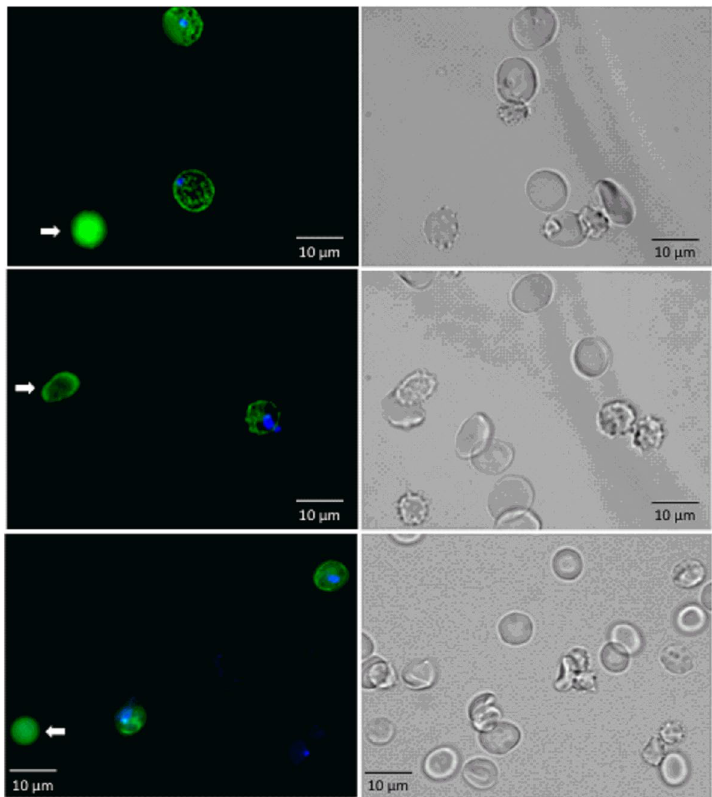
Figure 5. Fluorescence microscopy images of P.f.- RBCs after passing through the microfluidic devices (left column). Infected cells are shown as DAPI + RESA + (blue and green). White arrows indicate pitted cells (DAPI - RESA + , green). Corresponding bright field images of the same fields are shown in the right column. The images were obtained with an epifluorescence microscope (Leica AF6000) and modified using ImageJ software (version 1.41n Wayne Rasband, NIH, (https:// imagej. nih. gov/